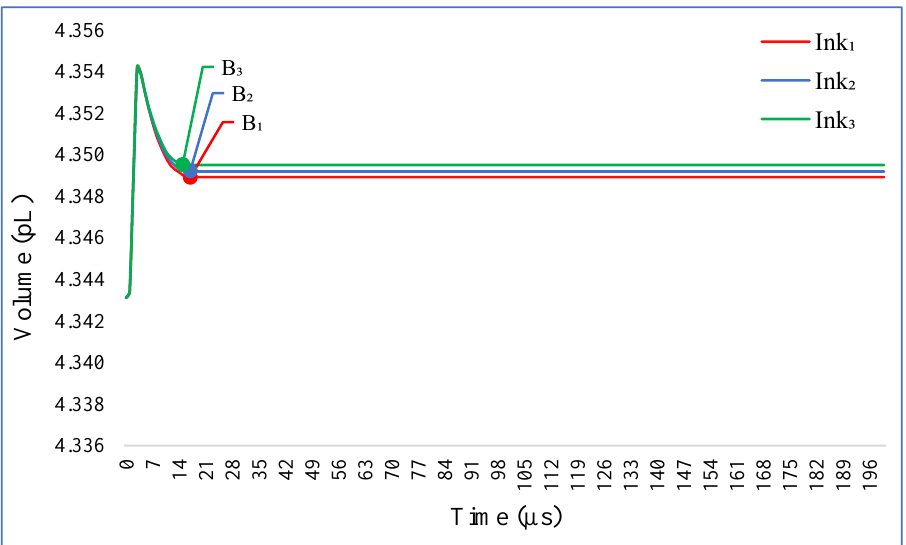
Figure 8. Representation of the volume versus time of droplets of Ink₁, Ink₂, and Ink₃. Droplets reach their final volume at the same instance as already obtained for the mass. Inks with highest density and viscosity reach the largest volume: Ink₁ droplet 𝑉 𝑑 = 4.3491 pL, Ink₂ droplet 𝑉 𝑑 = 4.3493 pL, and Ink₃ droplet 𝑉 𝑑 = 4.3495 pL.